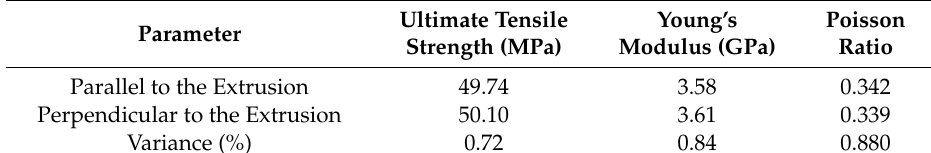
Figure 2. Dog-bone Coupon specimens prepared from the un-plasticized polyvinyl chloride (uPVC) tube (based on ASTM D638). Table 4. Average values from the tensile strength test.